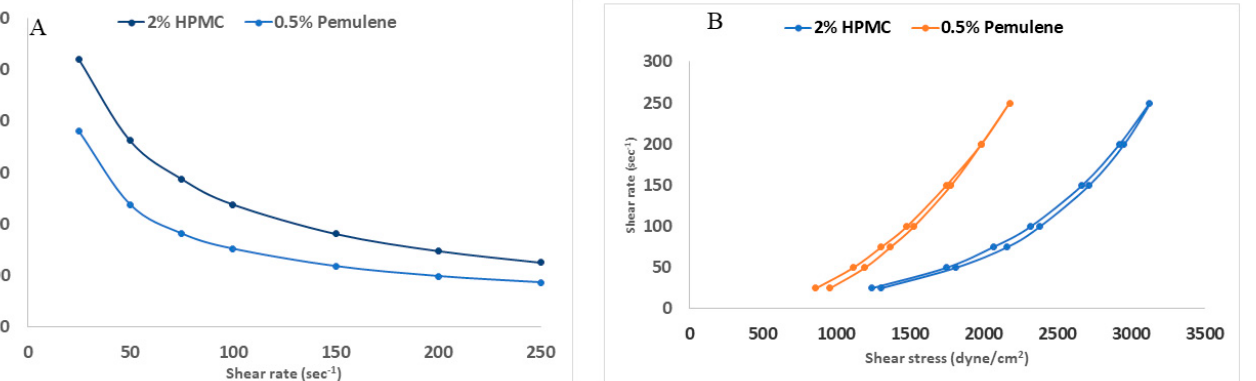
16 of 24 Figure 6. Transmission electron microscope image of the optimized zolmitriptan NLC (NLC9), ( A ), with scale, ( B ), without scale. 3.5. Characterization of NLC9 Loaded Gel Due to the lower viscosity of aqueous dispersions, NLCs are not sufficiently physi-